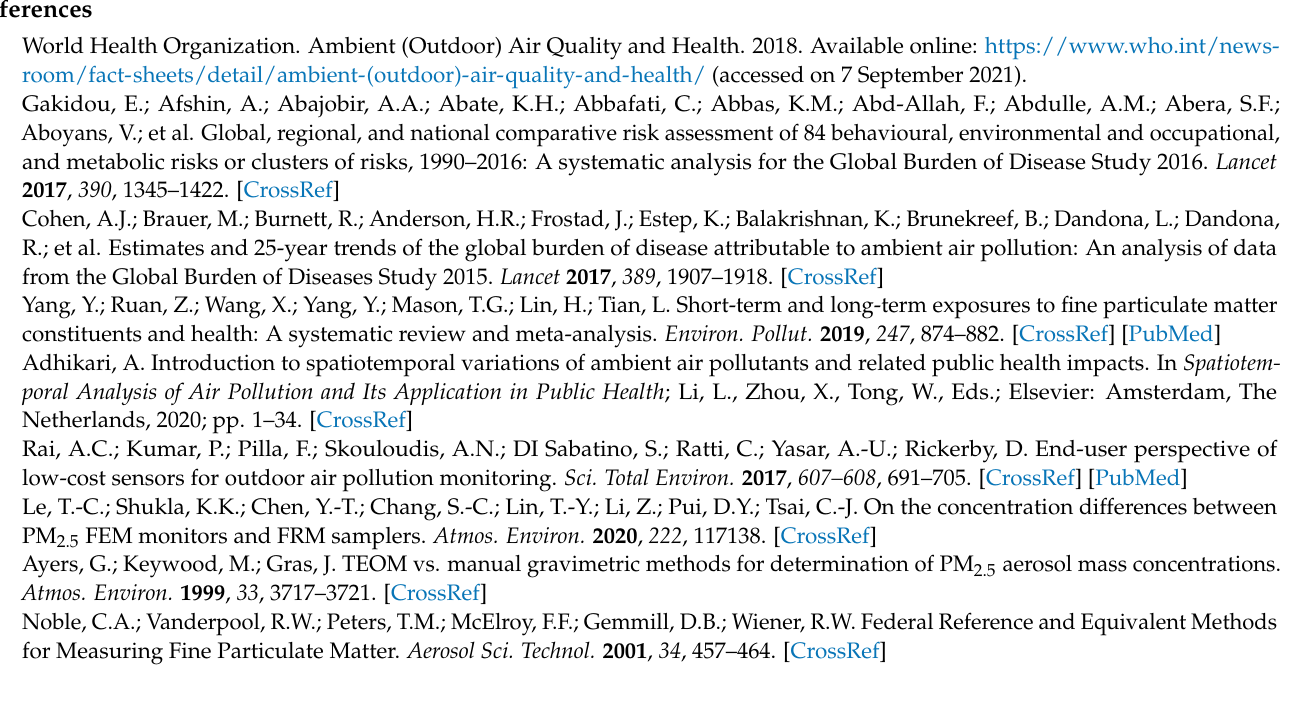
for the winter season; Figure S5: Histogram of variables for the spring season; Figure S6: Wind rose plots for the season of (a) Summer, (b) Autumn, (c) Winter and (d) Spring; Figure S7: Comparison of PM 2.5_REF , PM 2.5_LCS and PM 2.5_PRED for the season of (a) summer, (b) autumn, (c) winter and (d)